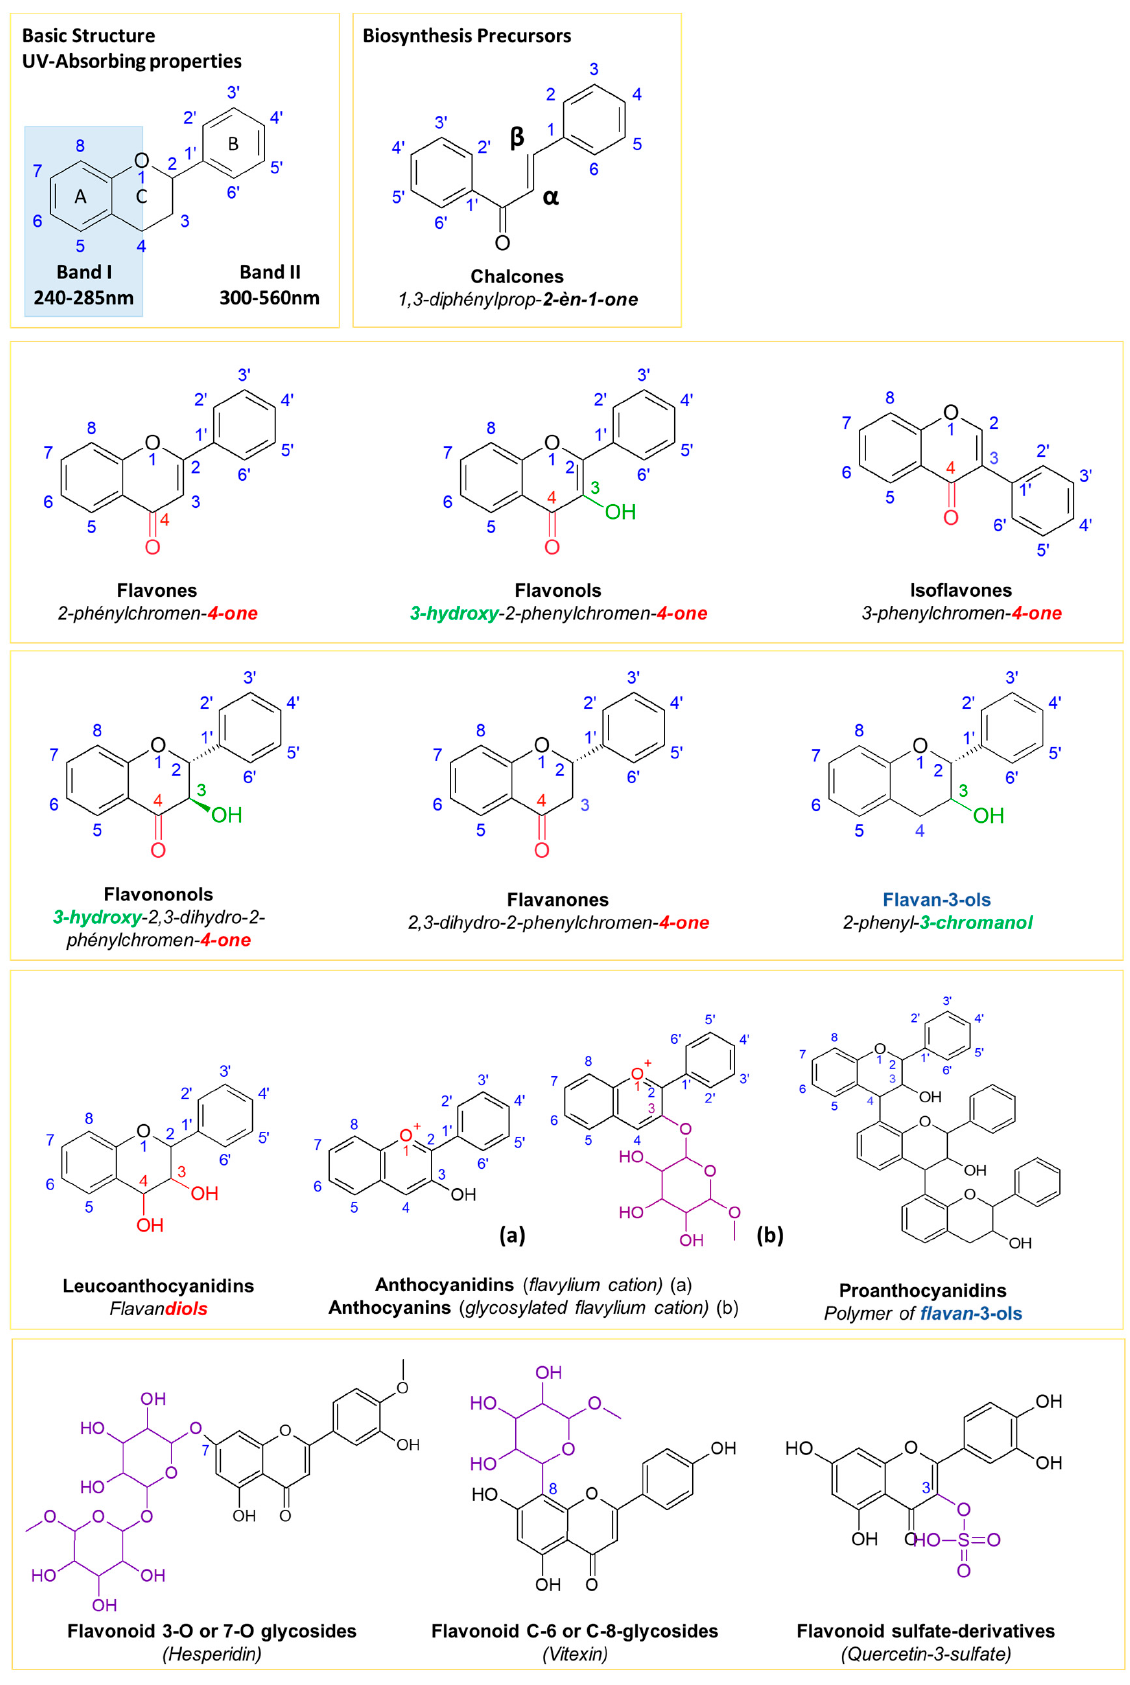
Figure 1. Classi fi cation of fl avonoids [8,22–25]. Figure 1. Classification of flavonoids